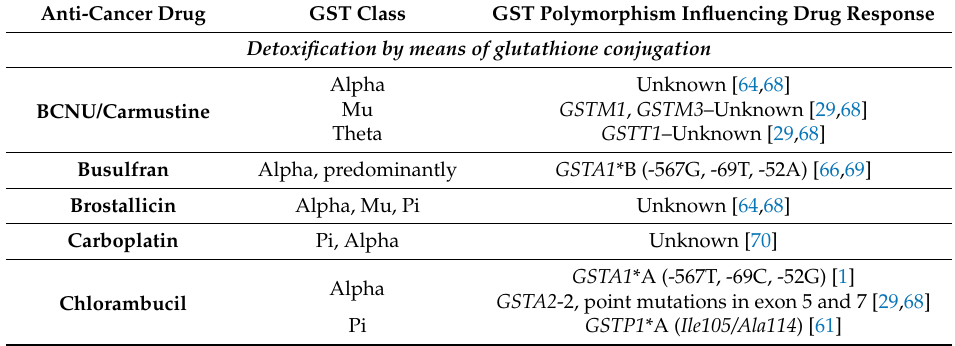
Table 1. GST polymorphisms influence the drug resistance mechanisms of conventional anti-cancer